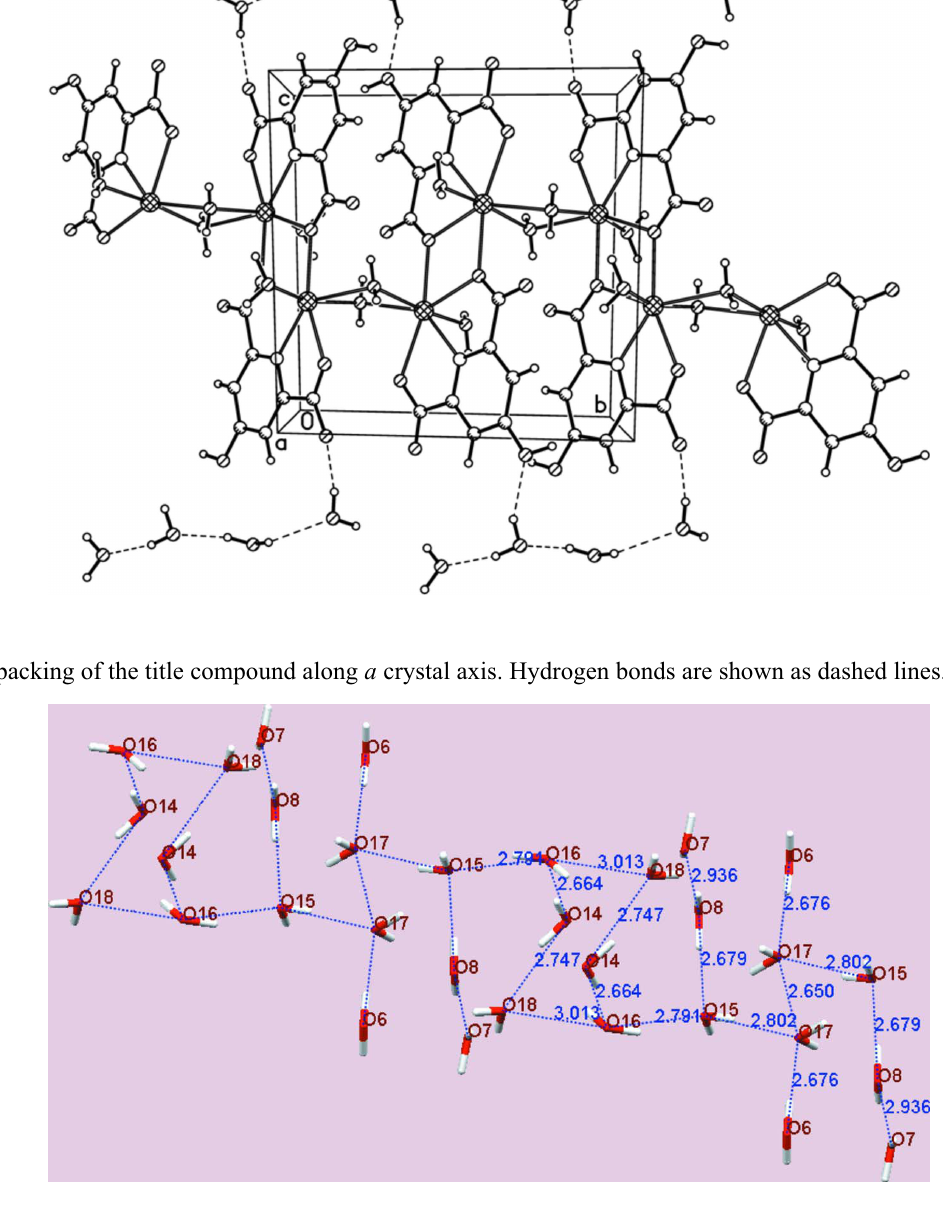
Figure 5 A perspective view of the water cluster arranged in the